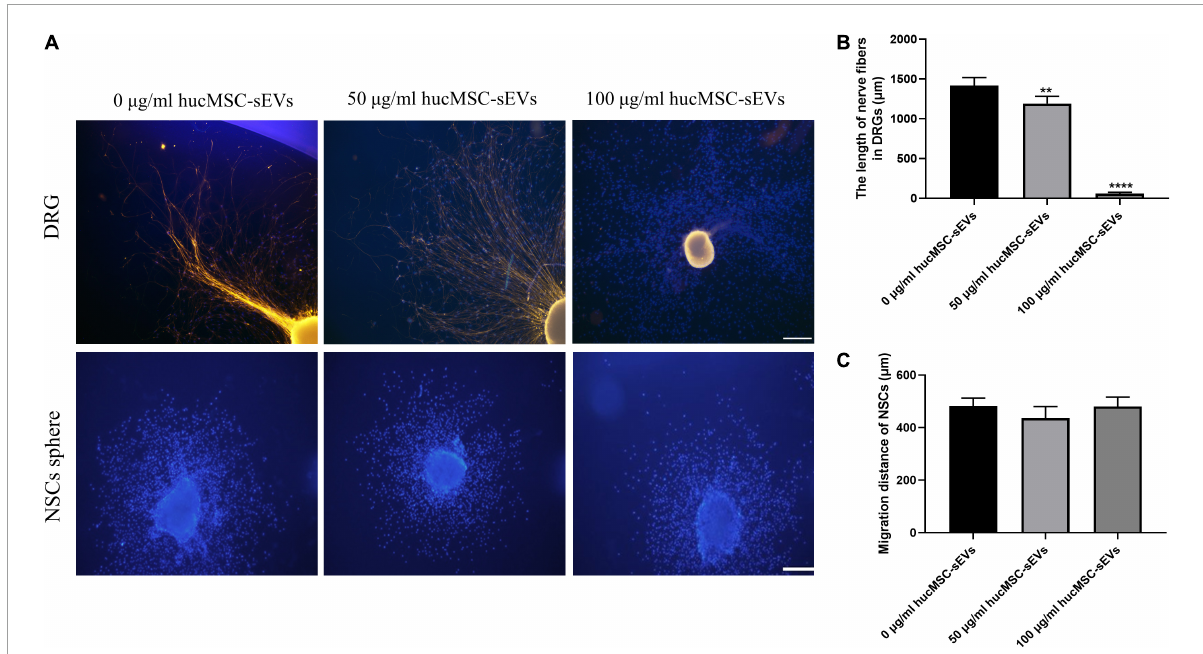
FIGURE4 Effects of hucMSC-sEVs on the migration of NSCs and the outgrowth of DRGs. (A) Representative immunofluorescence images of axonal marker β -III-tubulin staining in nerve fibers from DRGs and the radial migration test of NSCs from neural spheres in vitro . Scale bars, 100 µ m. (B) The quantitative analysis of the length of nerve fibers in DRGs. (C) The quantitative analysis of the migration distance of NSCs. The data are presented as means ± SD; n = 3; ** p < 0.01,**** p < 0.0001 vs. 0 µ g/mL hucMSC-sEVs